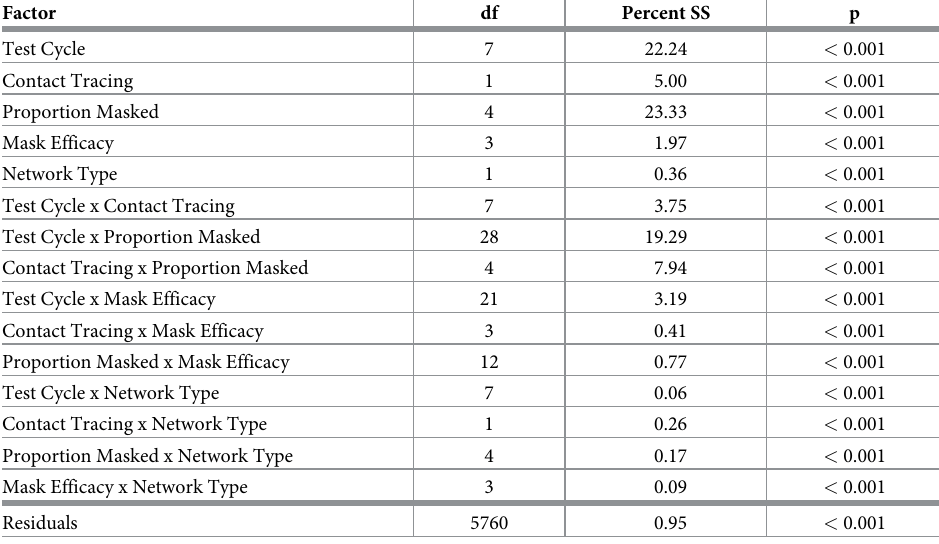
Table 2. ANOVA table for number of infections. The main effects and two-way interactions are shown as percentages of the sums of squares from the ANOVA. All factors and higher-order interaction terms were highly statistically signifi- cant (P < 0.001). The main and two-way interactions (shown) accounted for 88% of the variance (overall adjusted R 2 = 0.995). Factor df Percent SS p Test